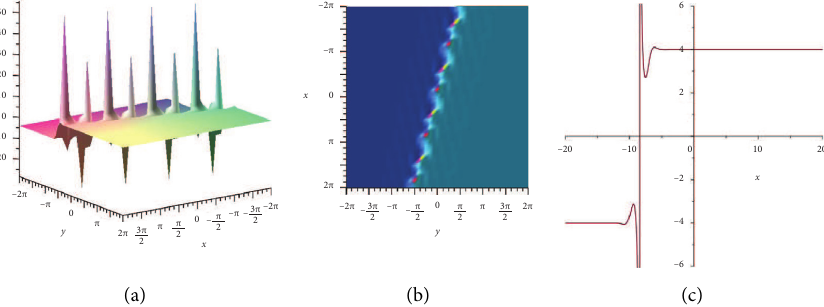
Figure 1: Breather wave (16) for equation (1) with ϵ the real part of the wave. (b) The overhead view of the wave. (c) The wave propagation pattern of the wave along the x axis with y � 0.